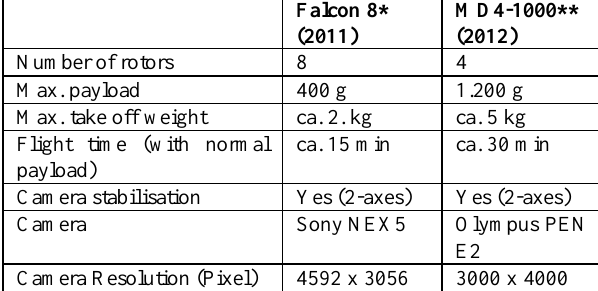
Table 1. UAS used for aerial surveys of bird reserve island Langenwerder 2011 and